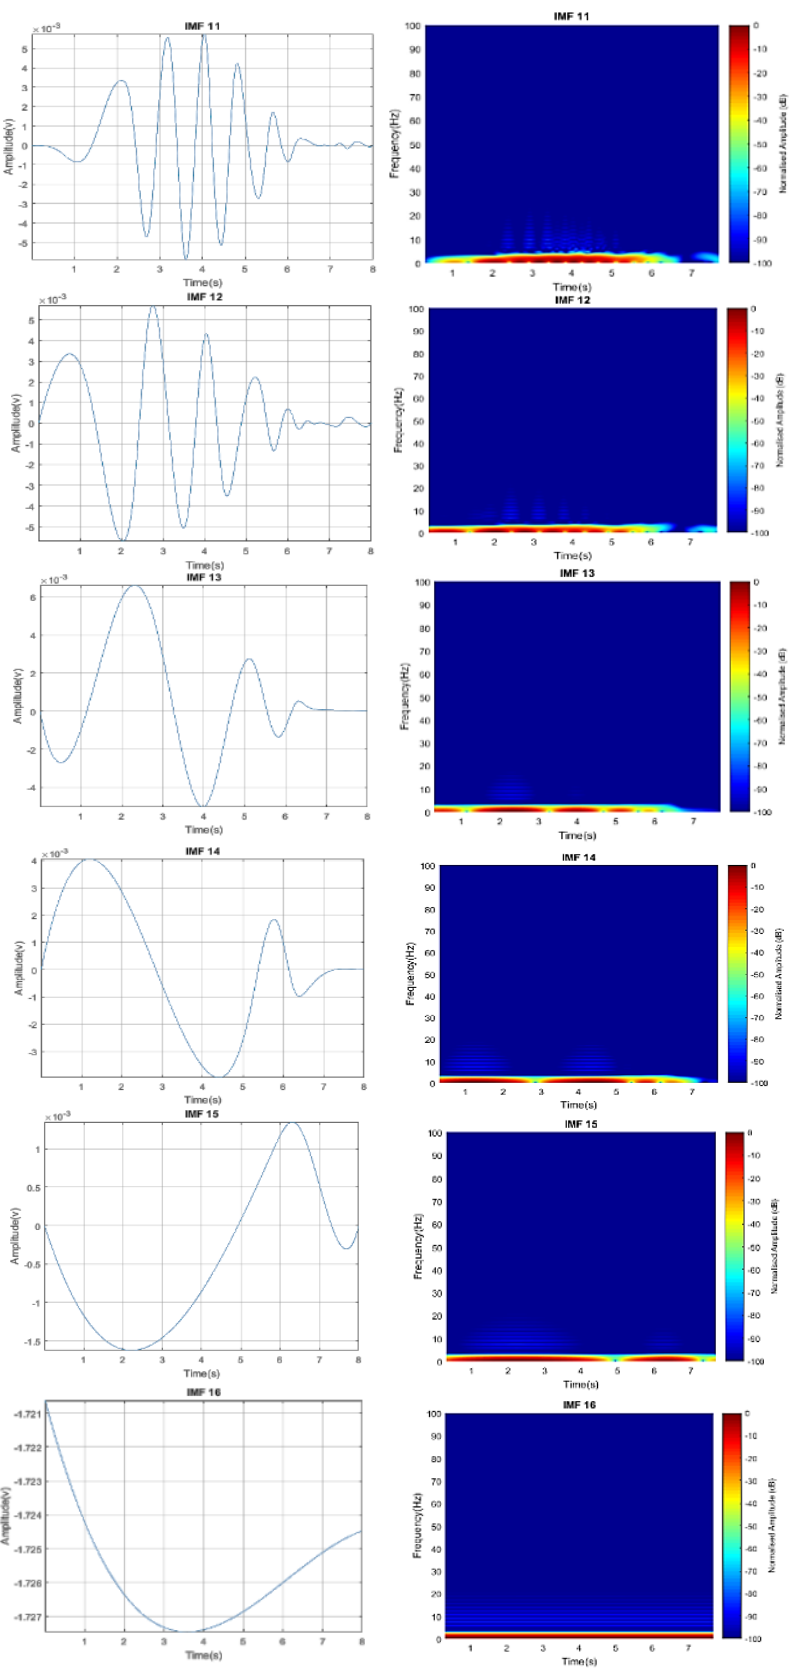
Figure 13. Time domain and STFT plot of IMF1-IMF16.